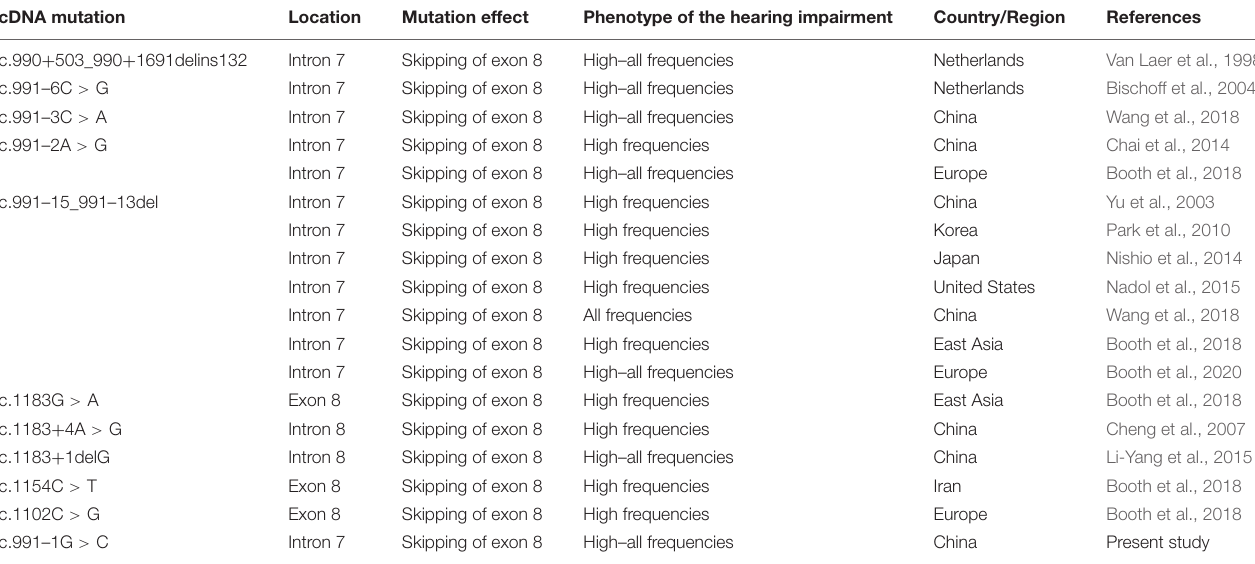
TABLE 1 | Summary of reported DFNA5